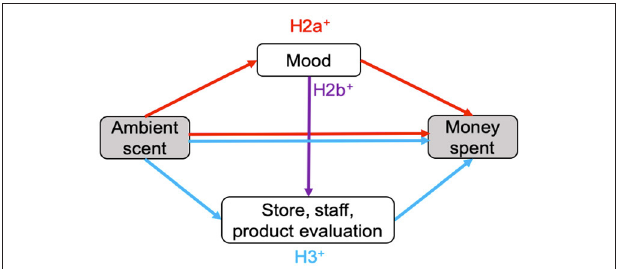
FIGURE 1 | Conceptual model with hypothetical pathways from ambient scent to spending. “Hot” affective route in red and “cold” semantic route in blue.